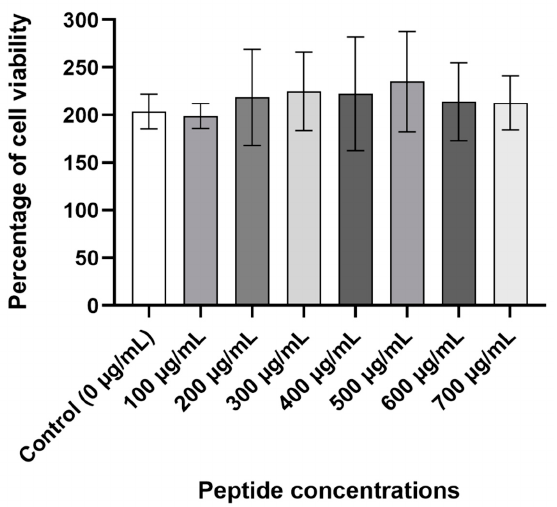
Figure 7. Percentage of cell viability caused by the different concentrations of peptide (from 100 to 700 μ